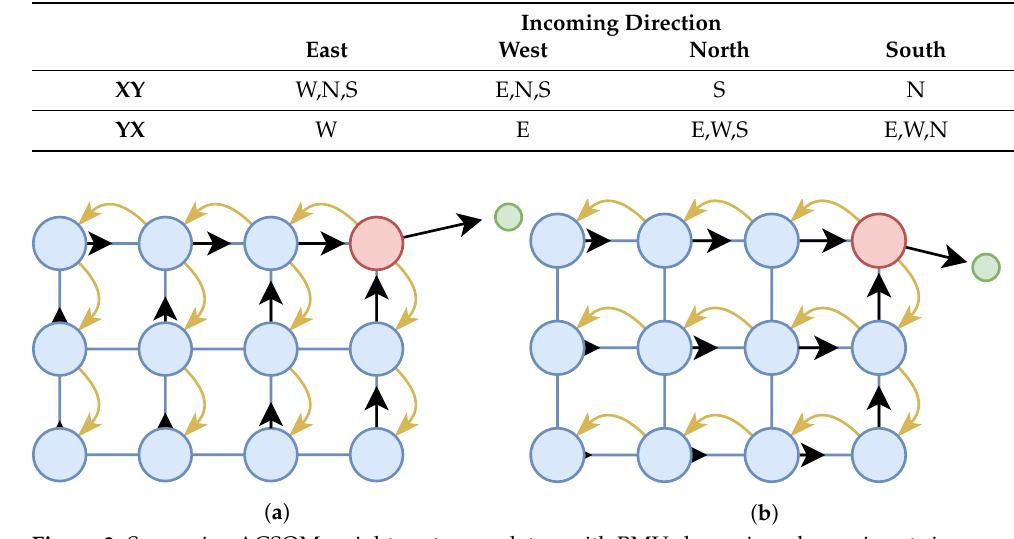
Figure 3. Successive ACSOM weight vectors updates, with BMU shown in red, new inputs in green, weight vectors represented as black arrows and update requests shown as yellow arrows. ( a ) Input x ( t ) with t BMU ≡ 0 mod 2 : ρ = XY . ( b ) Input x ( t ) with t BMU ≡ 1 mod 2 : ρ = YX